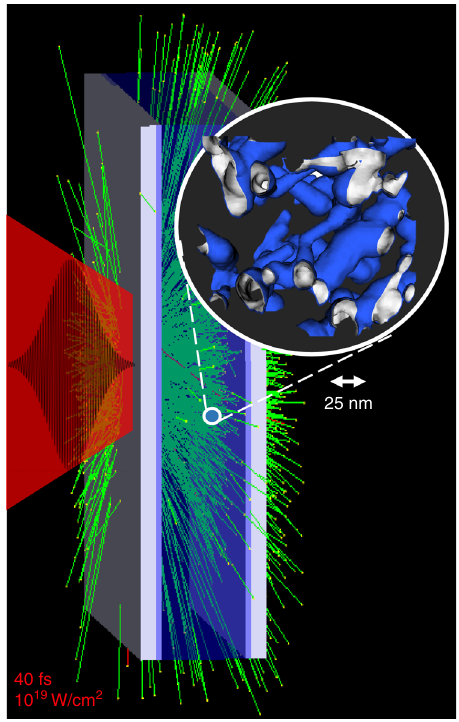
Fig. 1 Schematic setup of encapsulated nanofoam target. A laser pulse (40 fs long, 10 19 W/cm 2 , indicated in red) generates relativistic electrons that fl ood the target, causing quasi-static electric fi elds that expand the foam is 25